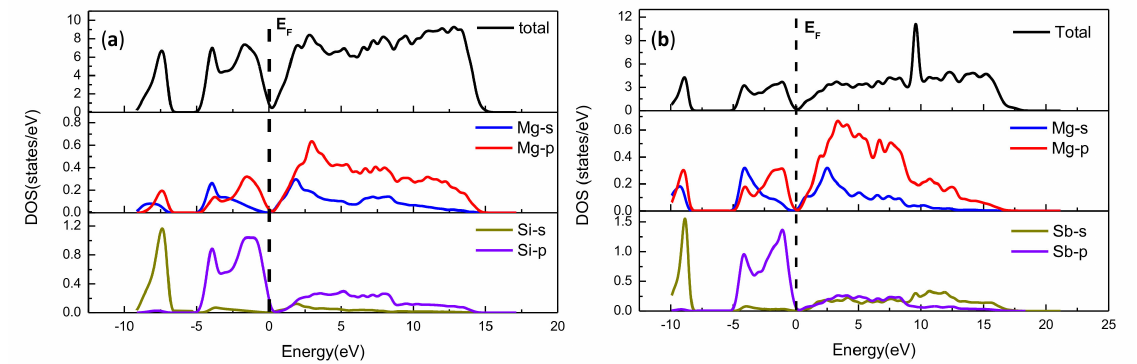
Figure 2. Partial density of state (DOS) charts of ( a ) Mg 2 Si and ( b ) Mg 3 Sb 2